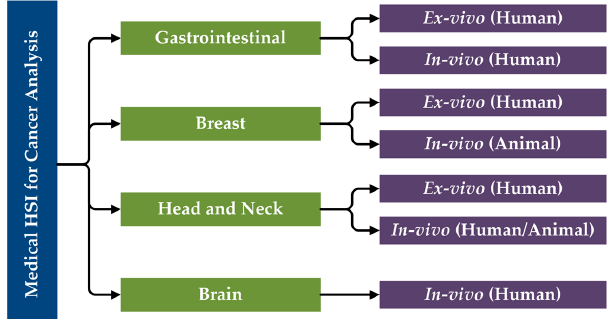
Figure 5. Taxonomy of the state ‐ of ‐ the ‐ art methods of medical HSI for cancer detection that are reviewed in this paper, organized by organ